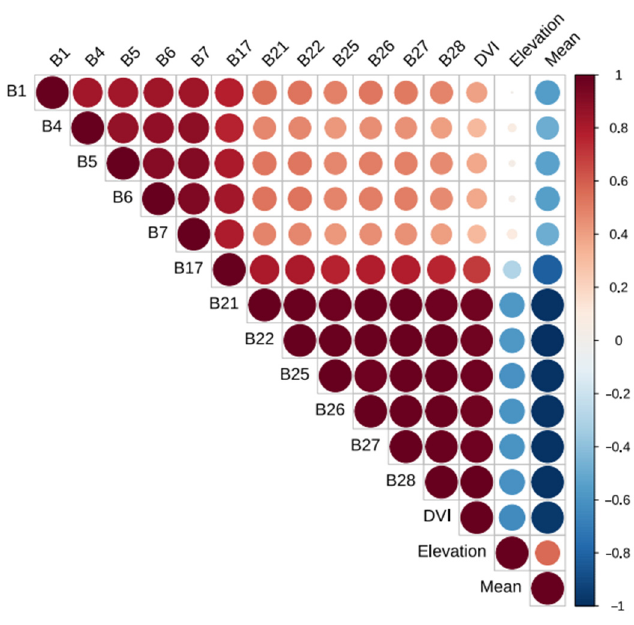
Figure 7. Spearman’s rank correlation coefficient for the 15 most important variables.